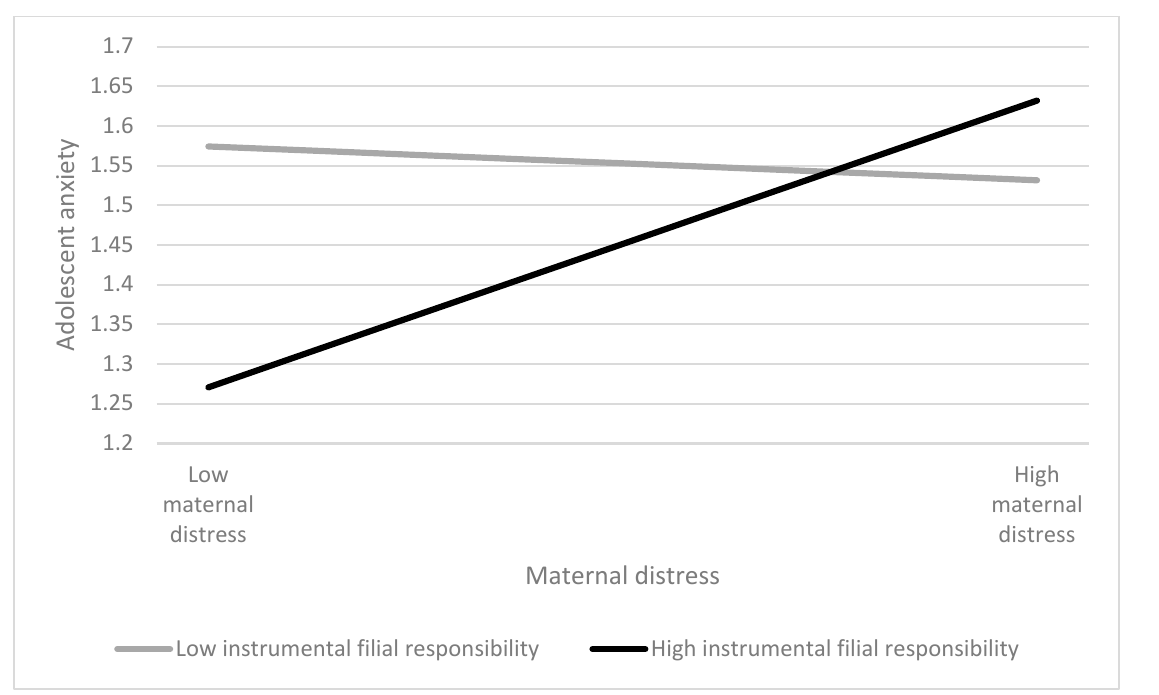
Figure 1. Regression of adolescent anxiety by maternal distress in high and low levels of instrumental filial responsibility.